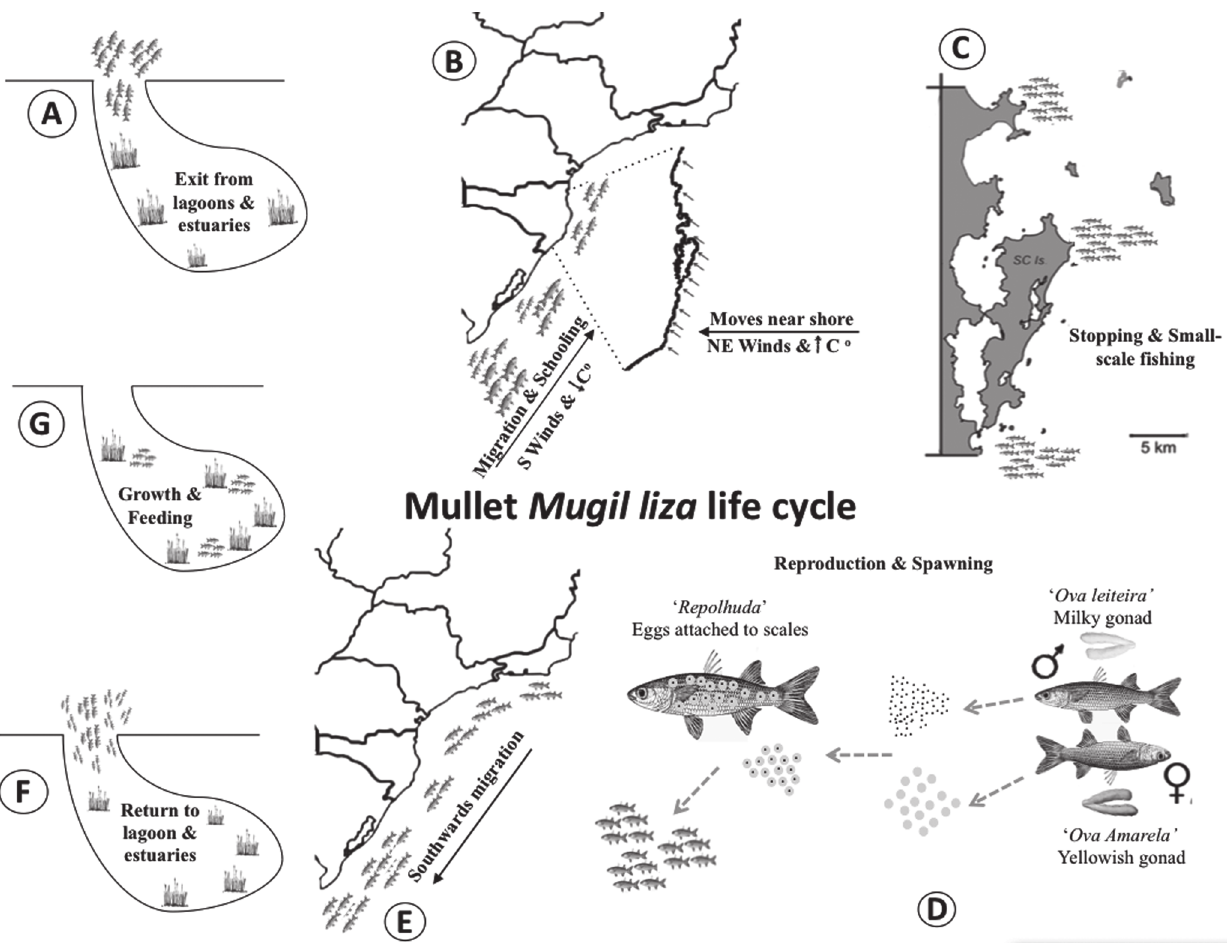
Fig. 2. The life cycle of the mullet Mugil liza following local ecological knowledge of fishers from Santa Catarina State: a) Exit of mullets from ‘criadouros’ or breeding sites (lagoons and estuaries) to the sea (n= 45); b) Migration of mullets known as ‘corrida’ (run) and recurrent gathering with smaller schools (schooling or thickening process). The outlined map represents the Santa Catarina State coastline and main stopping/fishing sites for mullets. Arrows corresponds to our data-collection sites, which were indicated as main fishing locations; c) Outline of Santa Catarina State island (Florianópolis city) and Bombinhas as most external (to the East) coastal areas and where larger captures of mullets occurs during the fishing season; d) Male and female spawning with respective milky (‘ova leiteira’) and yellowish (‘ova amarela’) gonads. According to most of our informants, after fecundation female mullets may hold their eggs under their scales until they become juvenile; e) Northward migration to São Paulo and Rio de Janeiro states, following by their (adults plus juveniles) southward return to lagoons and estuaries; f) Entrance of adult mullets and recruitment of juveniles in lagoons and estuaries; g) Growth and feeding of adults and juveniles in lagoons and